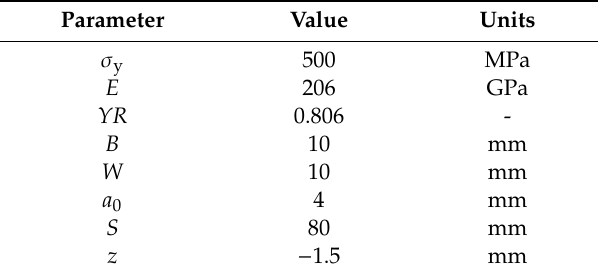
Table 1. Value of each parameter in the equations used for crack tip opening displacement (CTOD) calculations.